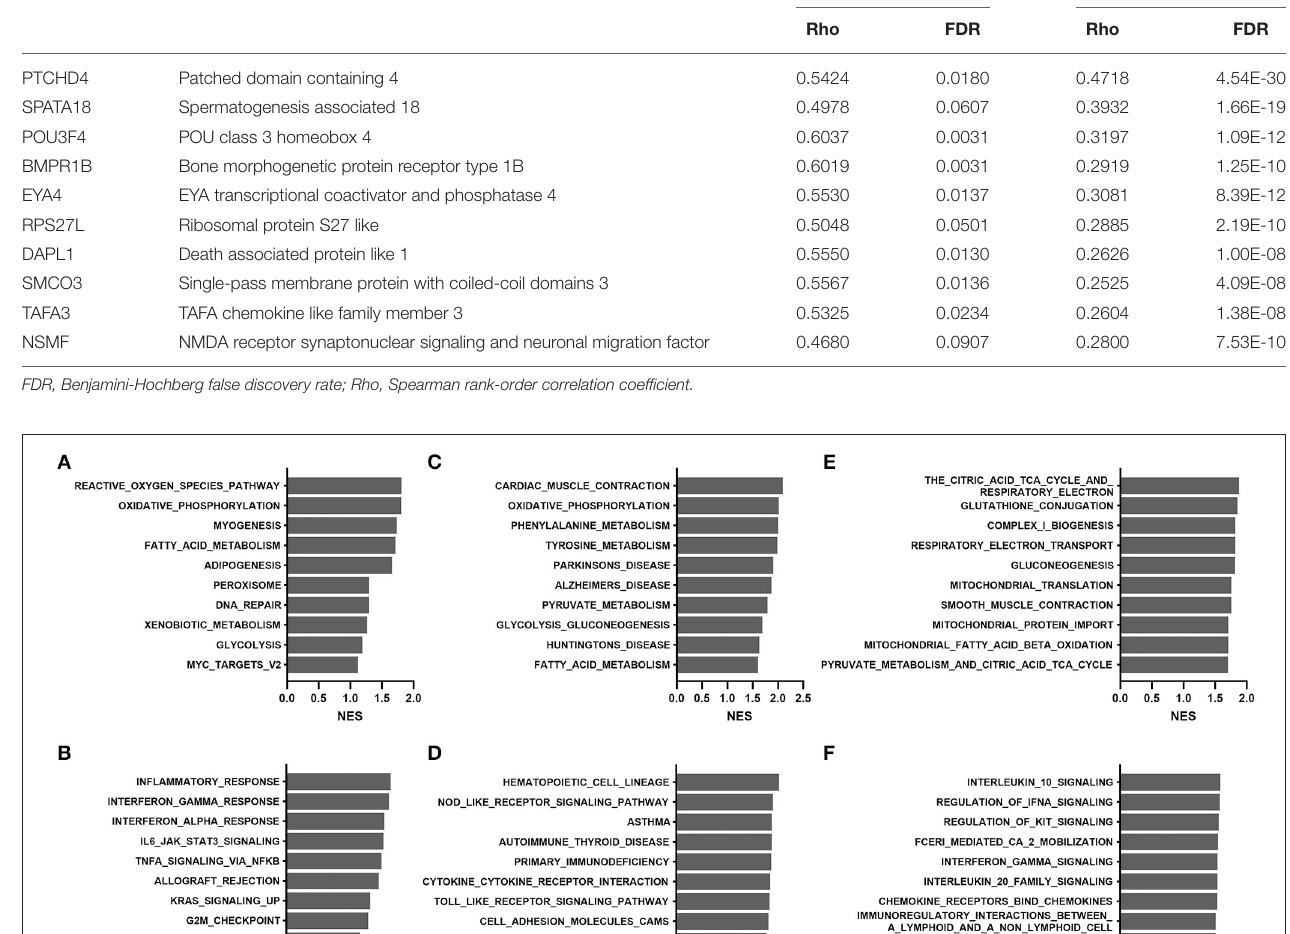
TABLE 1 | Top 10 aging-correlated genes in the thyroid gland. Gene